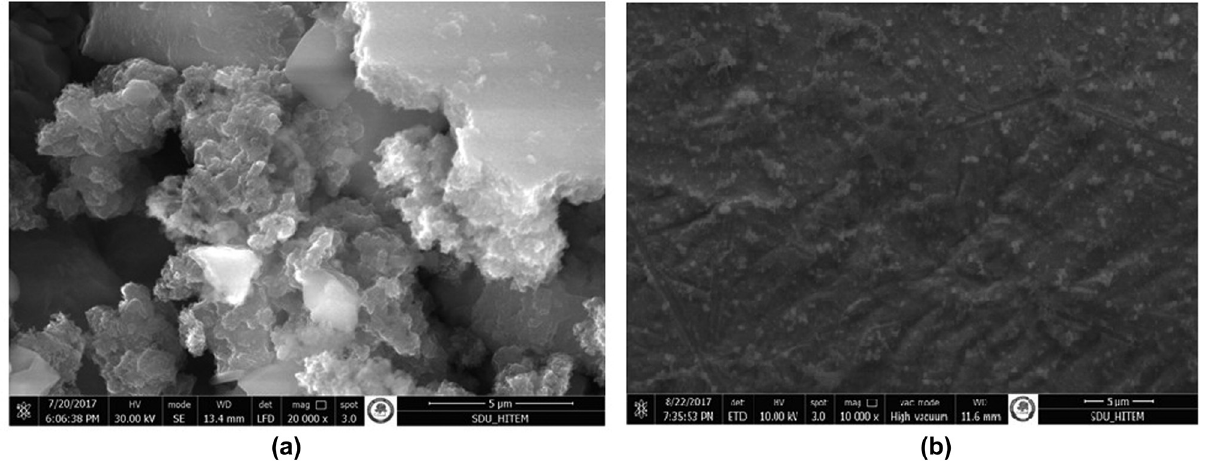
Figure 3: SEM images of ( a ) PEDOT and ( b ) EDOT/Th